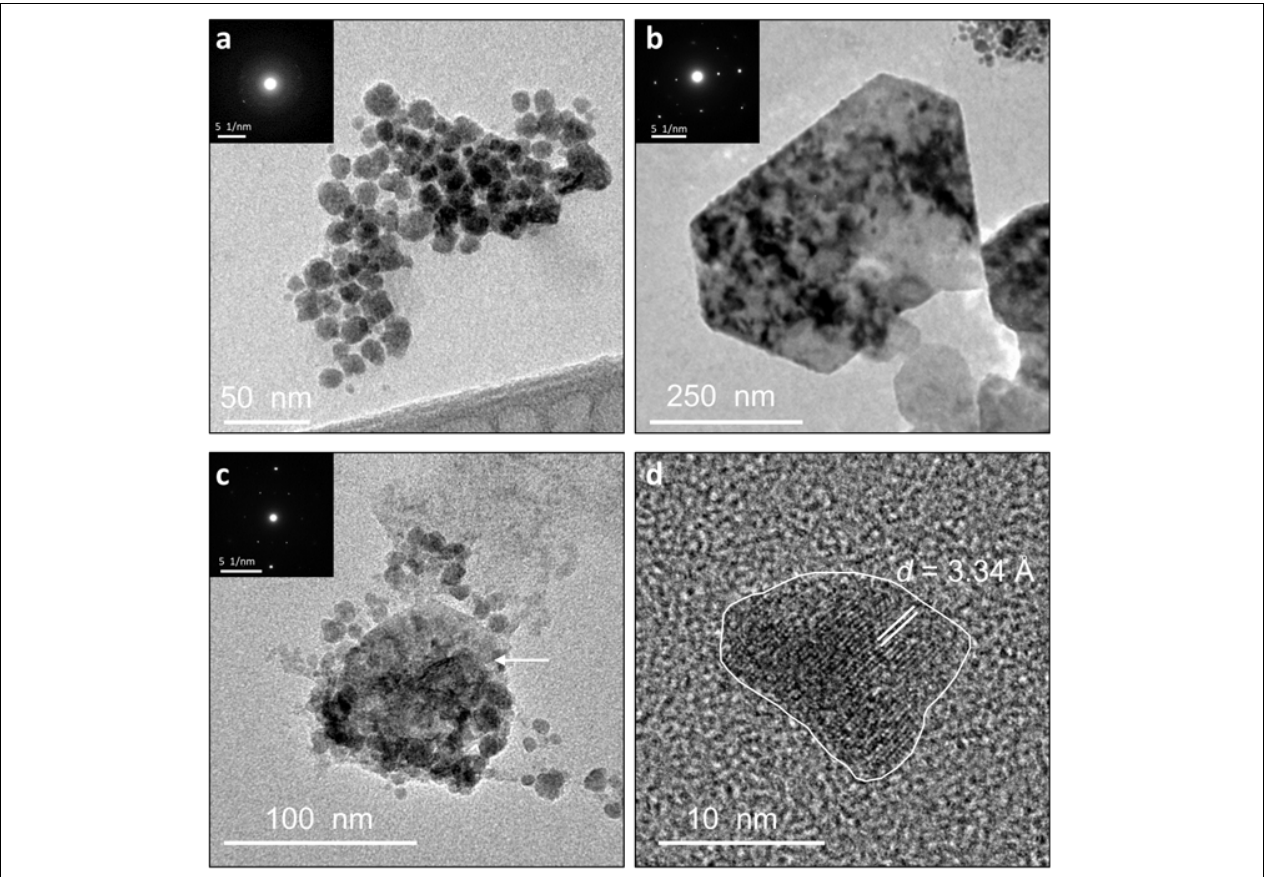
FIGURE 4 | TEM images of identified Ni-sulfide phases besides millerite. Insets show the corresponding SADPs. (a) Aggregates containing vaesite and polyphasic Ni-sulfide precursors. (b) Euhedral vaesite. (c) Larger-sized α -NiS nanoplate (denoted by the arrow) clustering with smaller polyphasic Ni-sulfide precursors and polydymite. (d) Irregularly shaped polydymite. Annotated SADPs are available in Supplementary Material